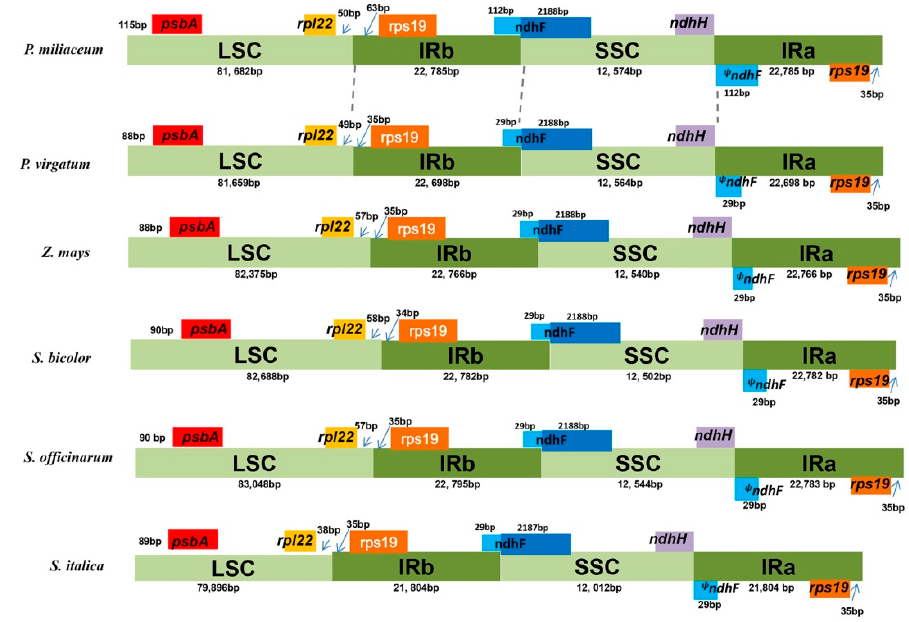
Figure 2. Comparison of the border positions of SSC, LSC, and IR regions among six Panicoideae chloroplast genomes.